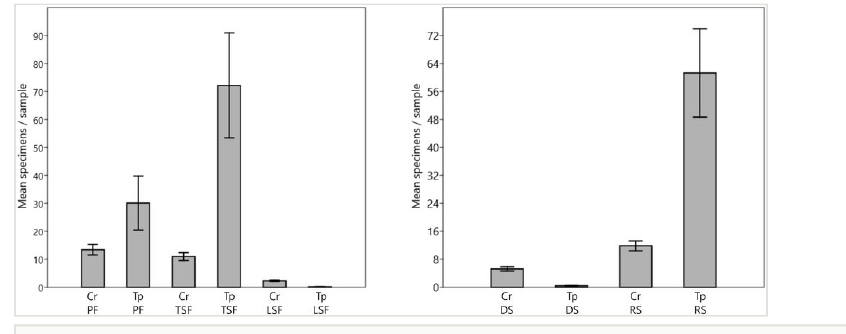
Figure 3. Mean number of specimens per sample (total of 3 traps; 195 samples/8 years), with standard error bars, comparing T. polita (Tp) with other Cryptinae (Cr) in three successional areas, primary forest (PF), tall secondary forest (TSF), and low secondary forest (LSF) (left chart), and in the dry season (DS) vs. rainy season (RS) (right chart). PERD.